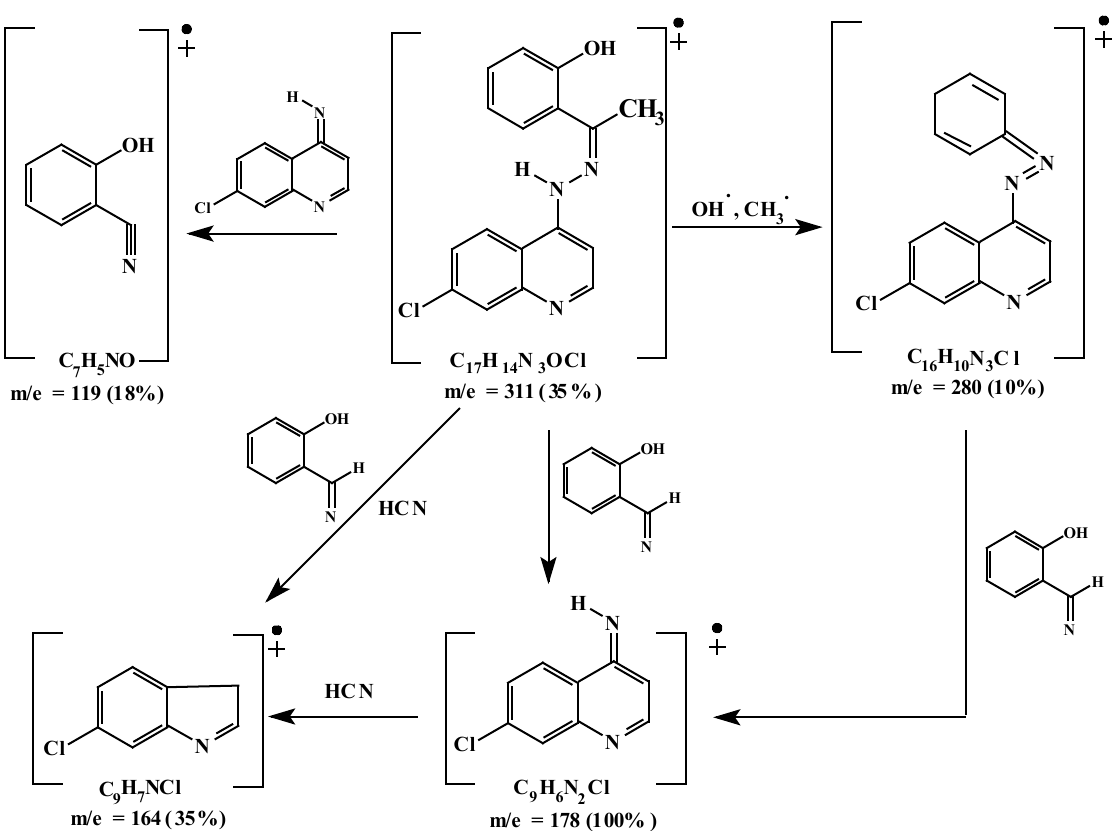
Figure 3. Mass fragmentation pattern of the ligand HL